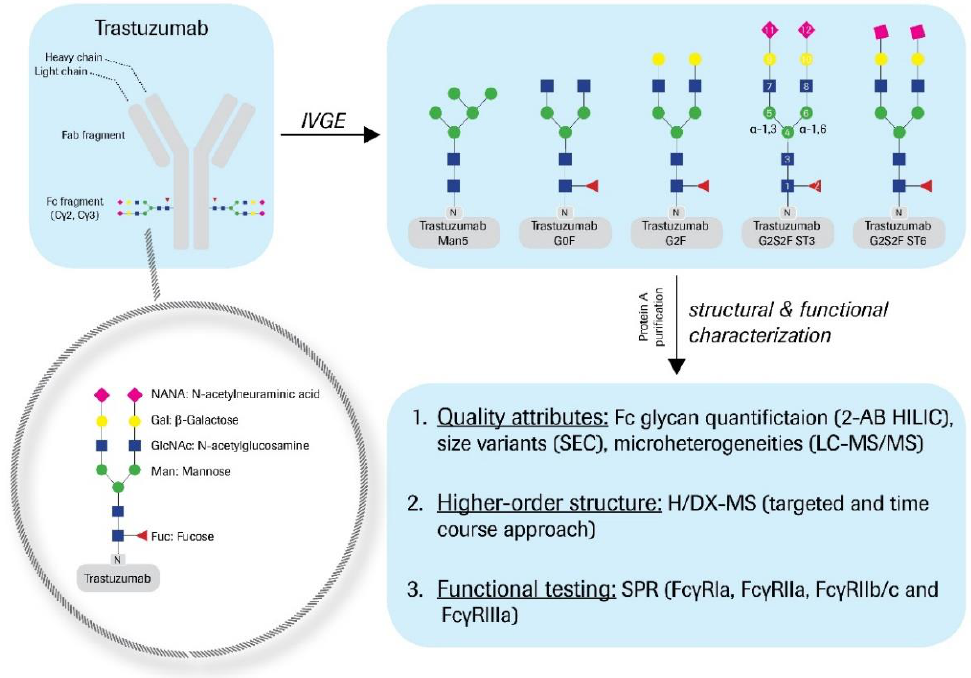
Figure 1. Study design. Trastuzumab drug substance (DS) was in vitro glyco-engineered (IVGE) with individual enzymatic post-process treatment, as described in the methods section. The trastuzumab Fc glyco-variants obtained (as determined by 2-AB HILIC; see Table 1 for details): G0F (81%), G2F (83%), G2S2F ST3 (60%), and G2S2F ST6 (43%). An additional trastuzumab Man5 variant (88%) was